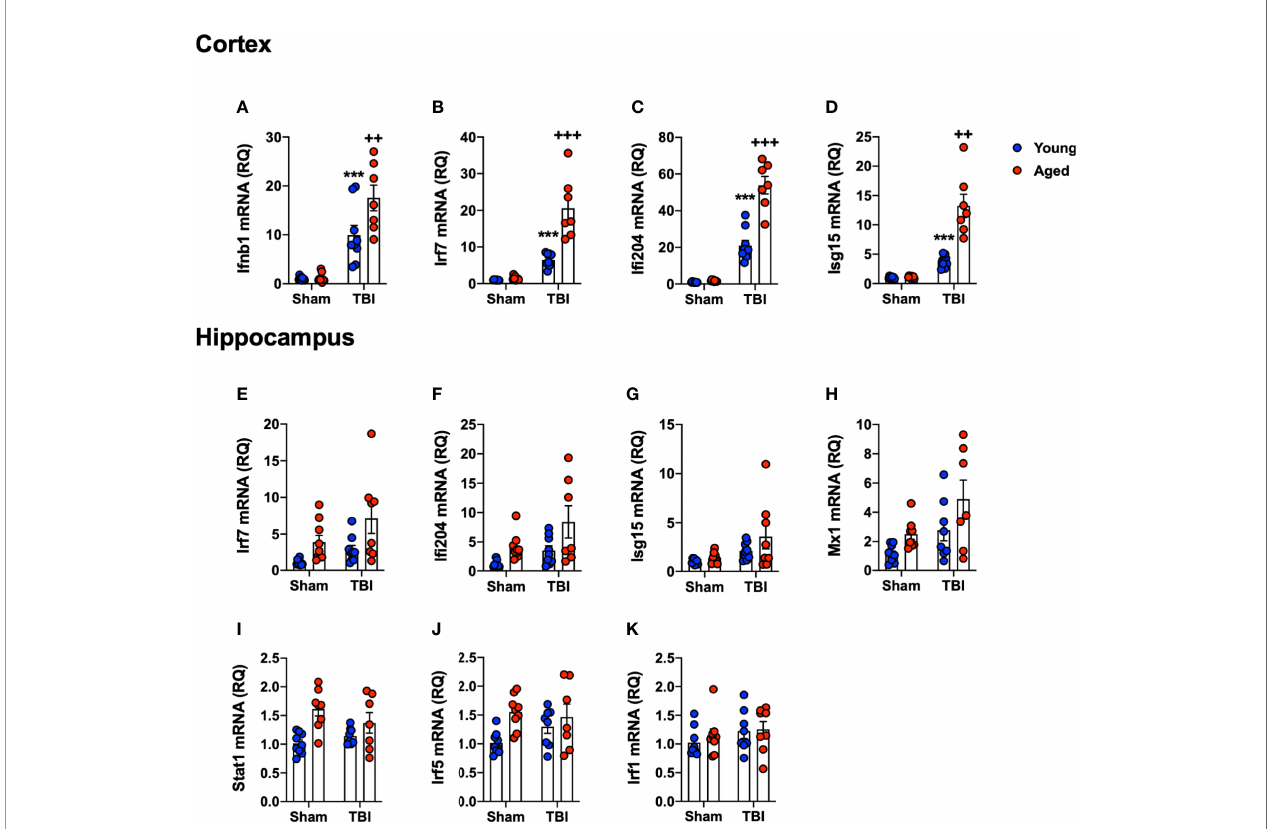
FIGURE 6 | Con fi rmation analysis of IFN-I genes the cortex and hippocampus of young and aged sham and TBI mice. Cortical and hippocampal expression of genes associated with IFN-I signature were assessed in young and aged sham and TBI at 24 hours post-injury. In the cortex, TBI signi fi cantly increased mRNA expression of Ifnb1 (p<0.0001, A ), Irf7 (p=0.0014, B ), I fi 204 (p<0.0001, C ) and Isg15 (p=0.0002, D ) in young and aged mice. The TBI-induced increase in Ifnb1, I fi 204, Irf7 and Isg15 was signi fi cantly elevated in the cortex of aged mice. In the hippocampus, TBI signi fi cantly increased expression of a number of IFN-I related genes in young and aged mice, Irf7 (p=0.0105, E ), I fi 204 (p=0.0133, F ), Isg15 (p=0.0135, G ) and Mx1 (p=0.0078, H ). Age also signi fi cantly increased expression of Irf7 (p=0.005, E ), I fi 204 (p=0.0028, F ), and Mx1 (p=0.0041, H ), but there was no signi fi cant interaction between age and TBI. Age signi fi cantly increased the expression of Stat1 (p=0.0006, I ) and Irf5 (p=0.0091, J ), but there was no effect of TBI on either gene. No effect of age or TBI was observed on Irf1 mRNA expression (K) . Data expressed as Mean ± SEM. ***p < 0.001 vs. sham (effect of TBI) and ++ p < 0.01, +++ p < 0.001 young TBI vs aged TBI. Two-way ANOVA using Tukey post-hoc tests,